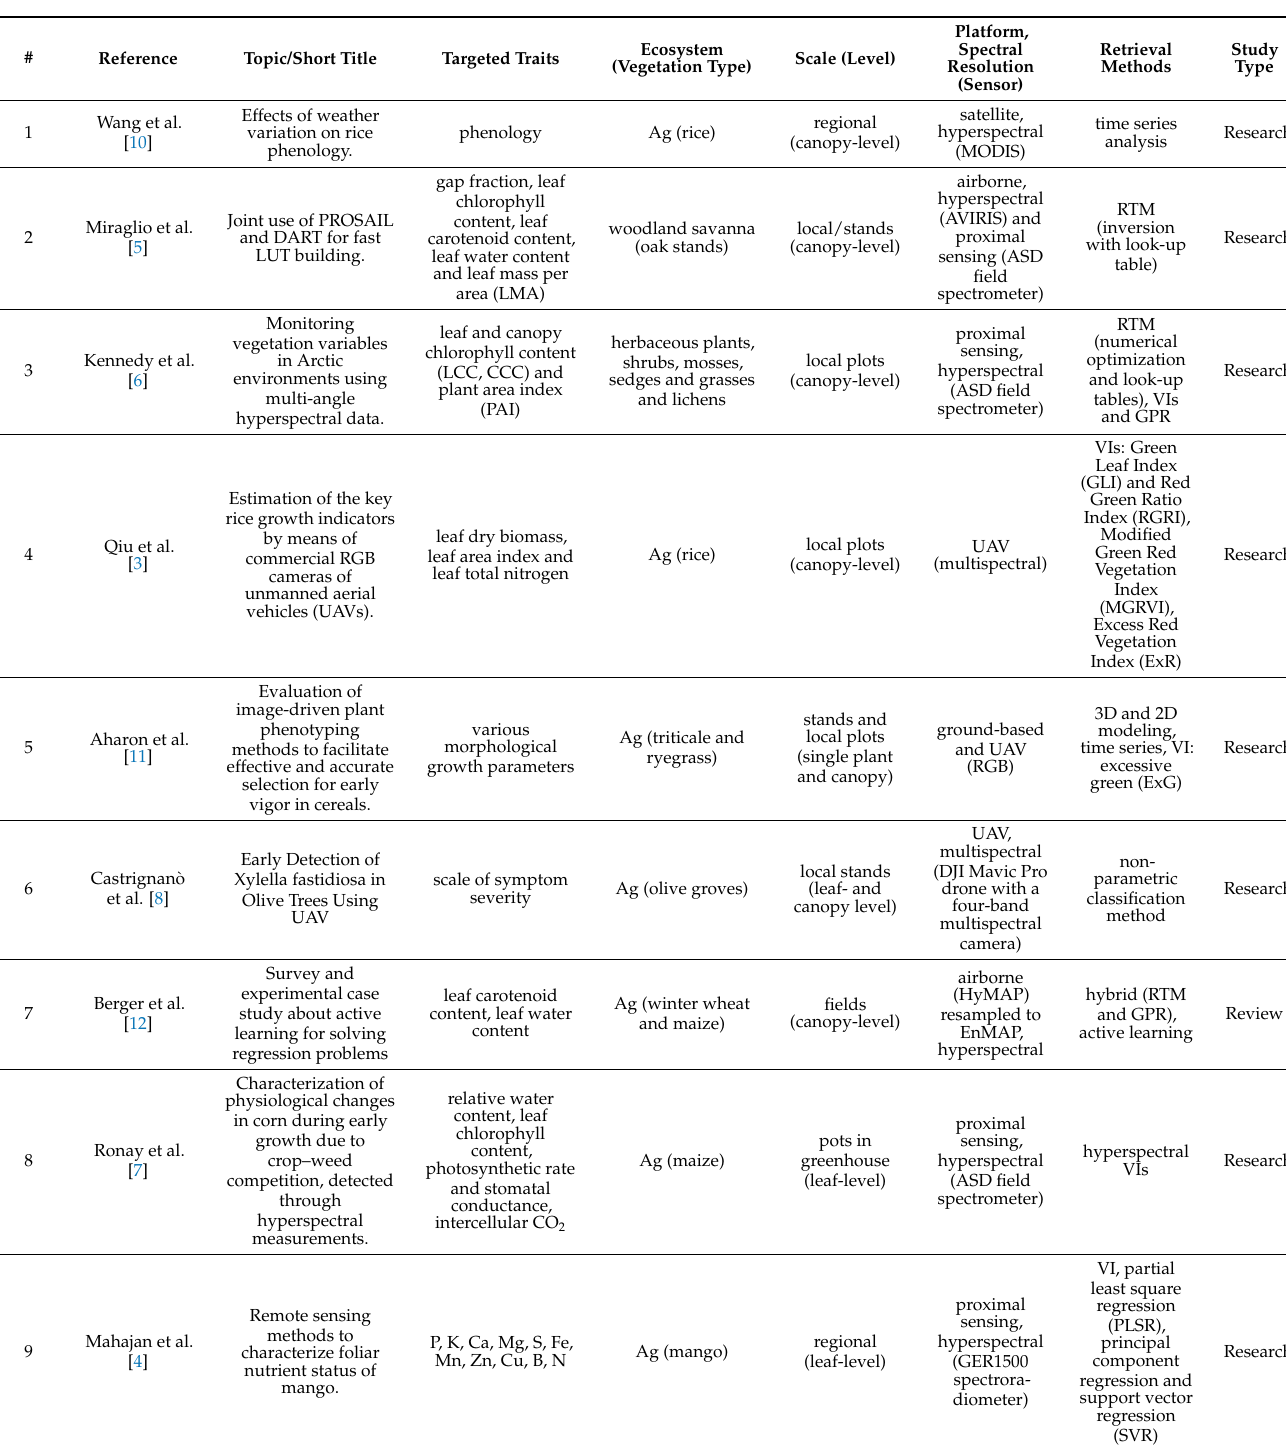
Table 1. Overview of papers published in the Special Issue (order in publishing date), with short description of objectives, targeted type of variables (traits), type of ecosystem/vegetation studied, scale (local/regional/global) including level (leaf, canopy or atmosphere), platform/sensors, spectral resolution and applied methods, as well as type of